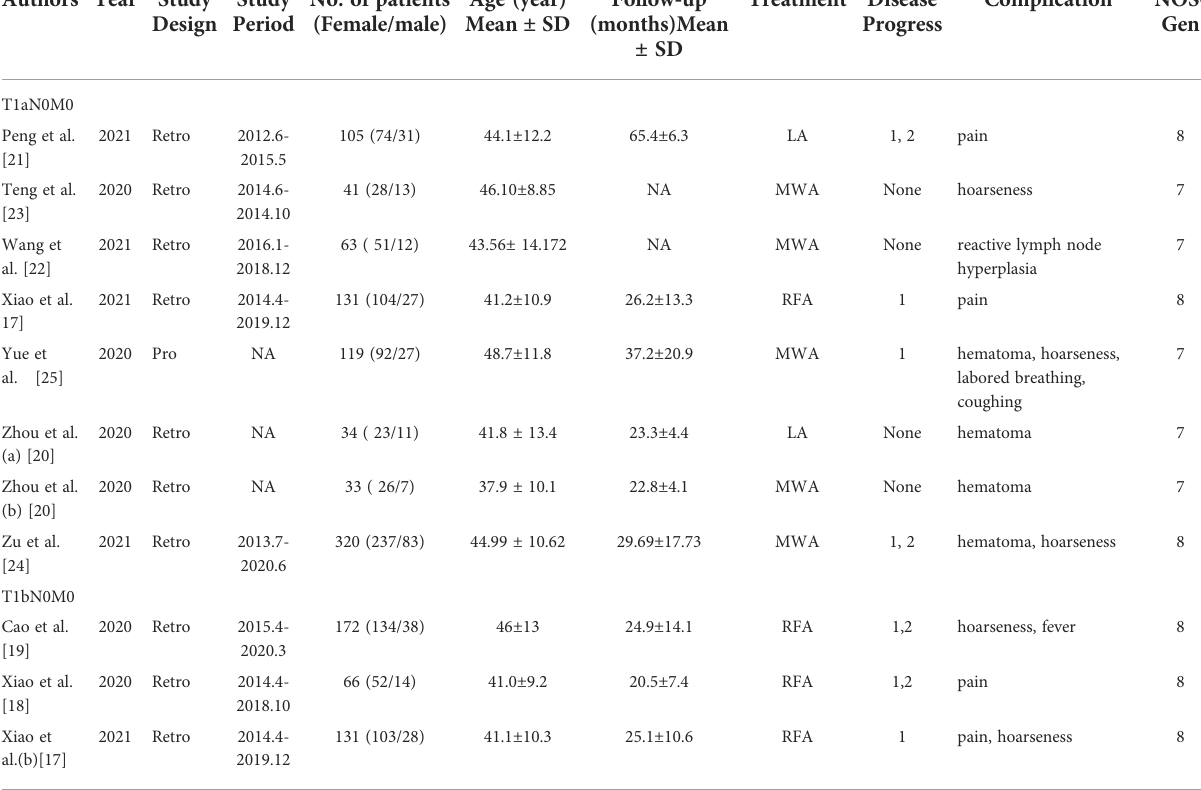
TABLE 1 Characteristics of the studies included in this